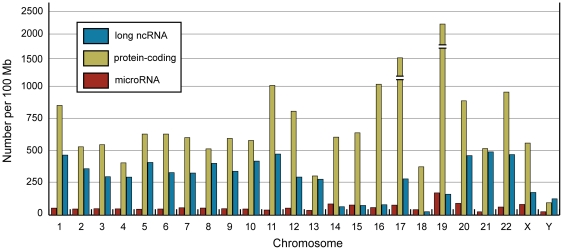
Chromosomal distribution of protein-coding genes, microRNAs and long non-coding RNAs in the human genome.Protein-coding gene (n = 20,655), microRNA (n = 1,746) and long non-coding RNA (n = 9,891) coordinates were downloaded from Ensembl v62 using BioMart.